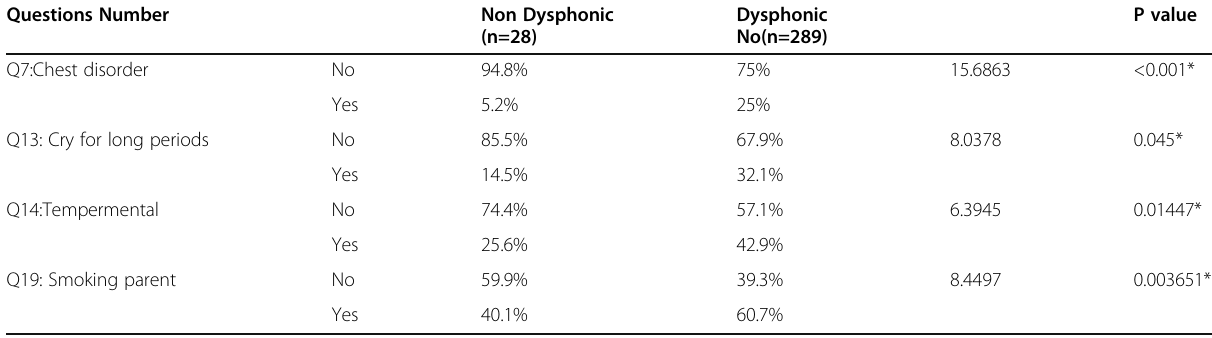
Table 2 The significant correlation between the presence of dysphonia and possible predisposing factors. Questions